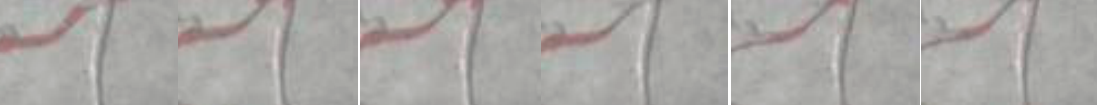
Figure 16. Variation of remaining columnar oil in the same area with different displacement rates (the time from left to right was 729, 1160, 1500, 1990, 2300, and 2633 s). The results show that the ultimate displacement efficiency of contiguous remaining oil increased by 55.30% with the increase in displacement rate. The ultimate displacement efficiency of branched remaining oil increased by 93.67%, which shows that increasing displacement rate has a noticeable effect on the development of branched remaining